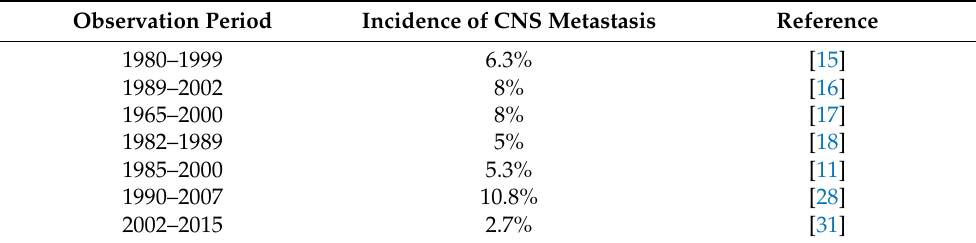
Table 3. Main studies reporting occurrence of CNS metastasis in NB are